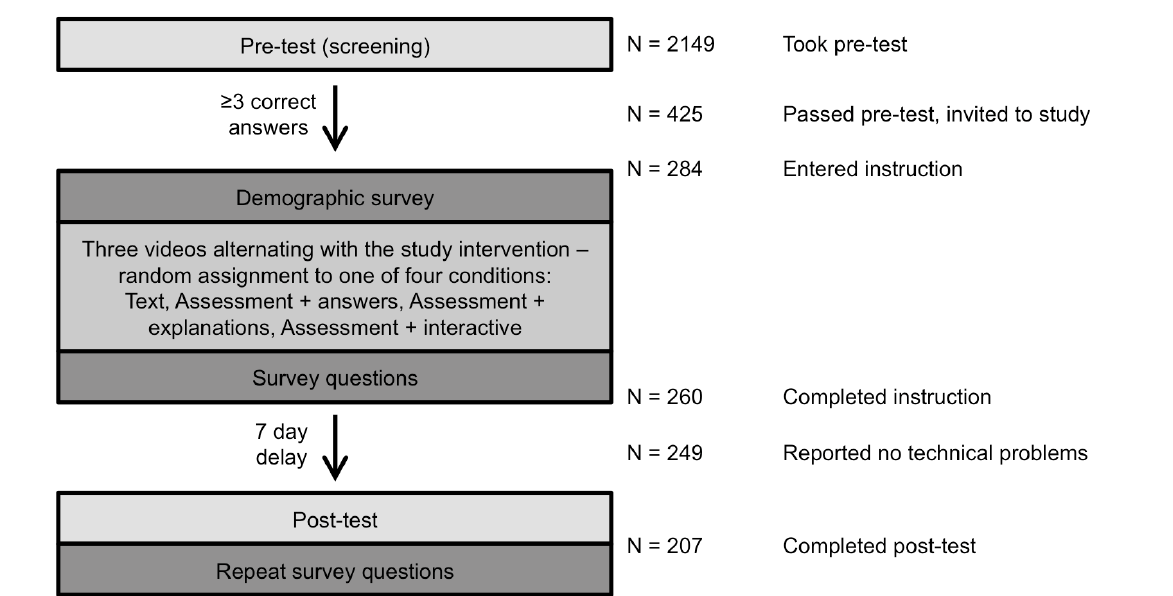
Figure 1. Overall study workflow and participant retention in the study. The phases of the study are indicated in the diagram on the left, while the number of participants at each phase are indicated on the